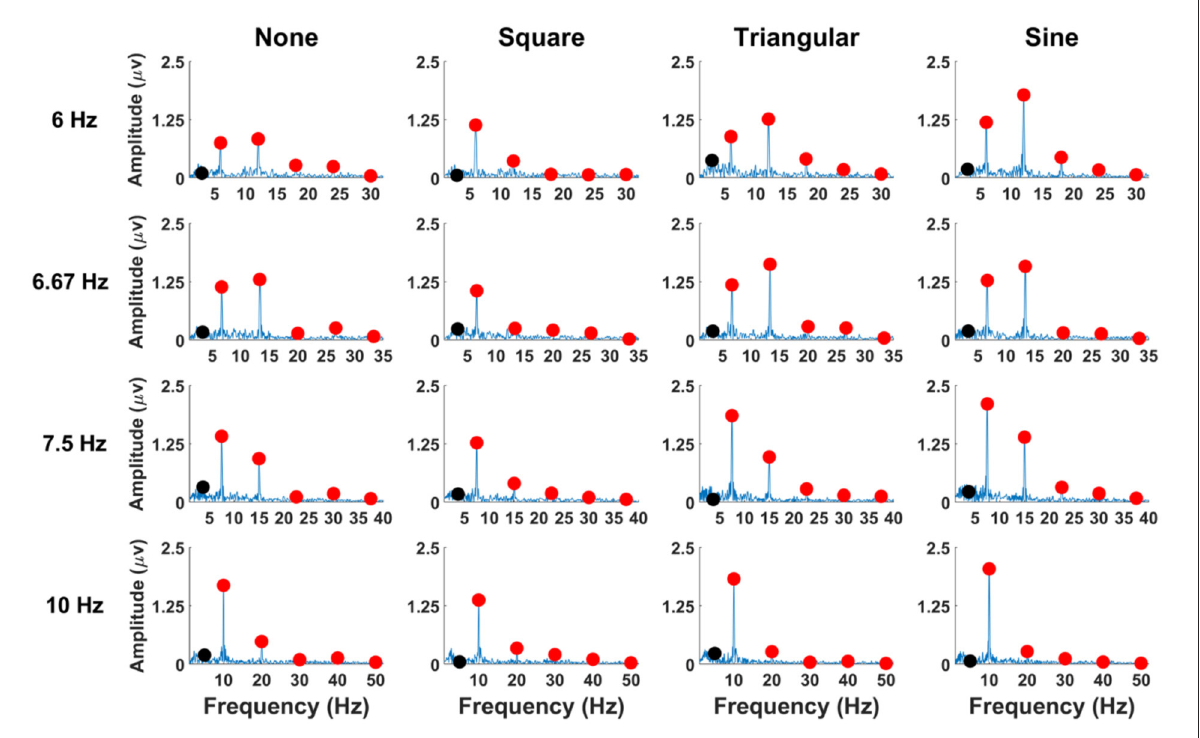
FIGURE3 SSVEP amplitudes of the averaged EEG signals across all the participants at the Oz electrode for FS-based hybrid visual stimuli. Red circles indicate the stimulation frequencies and their harmonics, and black circles represent the subharmonic